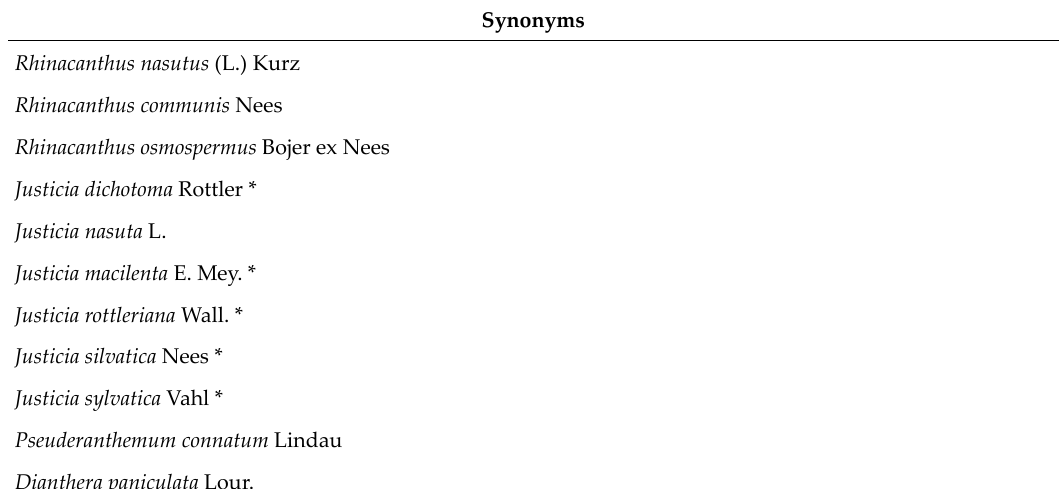
Table 1. List of common / regional names of Rhinacanthus nasutus (L.) Kurz.